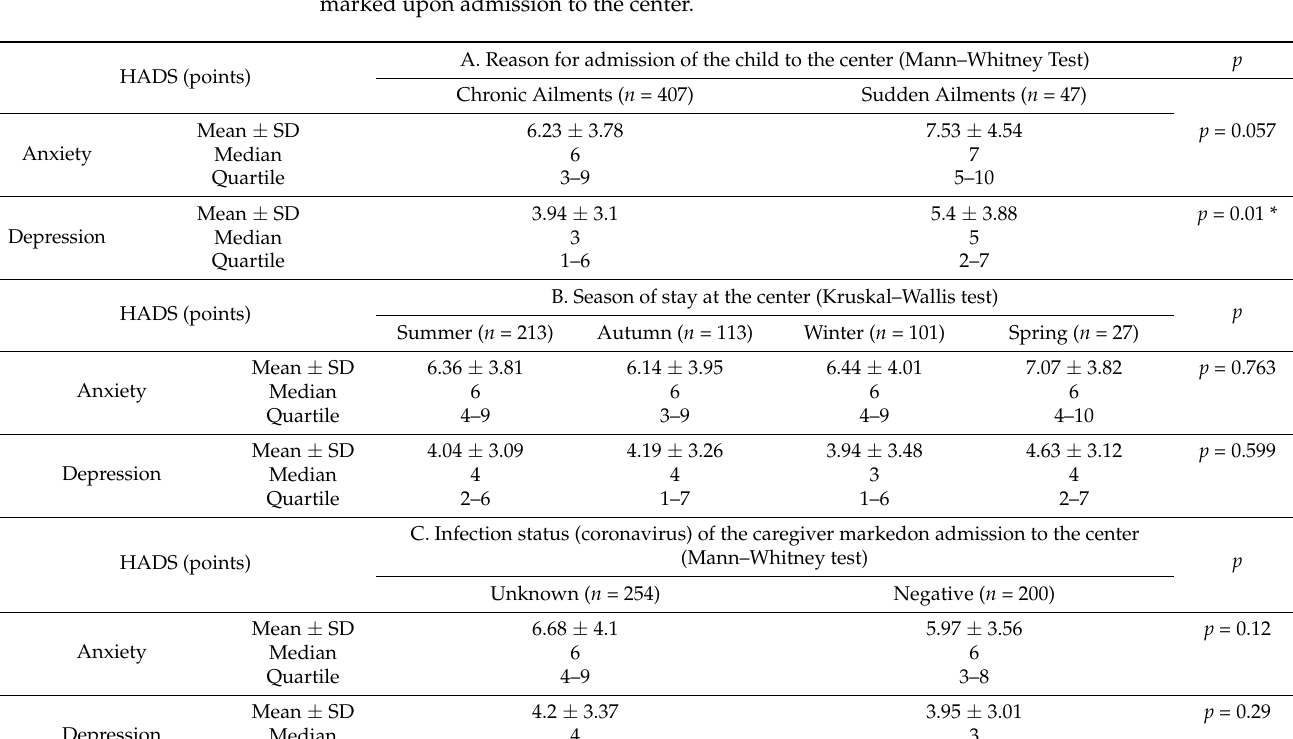
Table 9. Reason for admission to the center (A), season of the year during which the stay in the